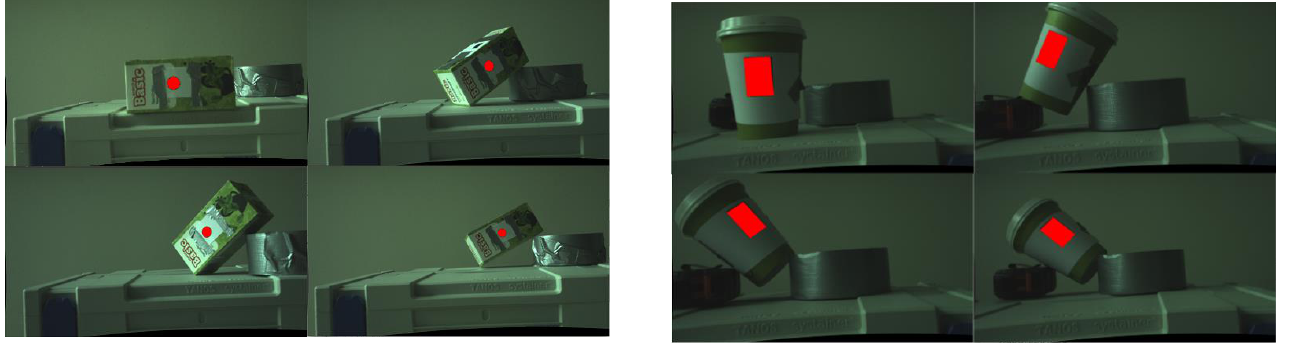
Fig. 3. Object recognition with black circle mark from different positions and orientation in dark condition.